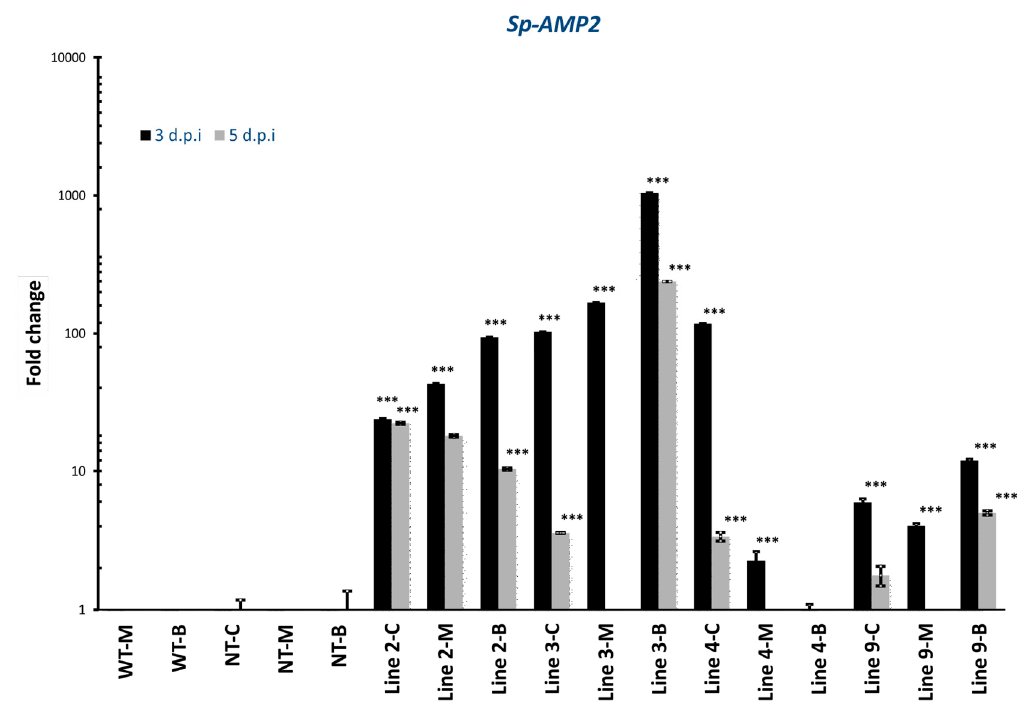
Figure 5. Quantitative real ‐ time PCR analysis of expression patterns of Sp ‐ AMP2 in different tissues and in response to various treatments at 3 and 5 days post ‐ inoculation. Sp ‐ AMP2 relative expression levels were determined as described earlier (Livak and Schmittgen 2001 [34]) and normalized with Elongation factor 1a ( EF ‐ 1a ). WT ‐ M, untransformed wild ‐ type tobacco mock treated with PDB (Potato Dextrose Broth); WT ‐ B, untransformed wild ‐ type tobacco infected with B. cinerea ; NT ‐ C, non ‐ transgenic tobacco not treated control; NT ‐ M, non ‐ transgenic tobacco mock treated with PDB; NT ‐ B, non ‐ transgenic tobacco with independent transgenic tobacco infected with B. cinerea ; Line 2; Line 3; Line 4; Line 9, independent transgenic line expressing Sp ‐ AMP2 with either non ‐ treated control (C), infected with B. cinerea (B), or mock treated with PDB (M). Data represent the fold change of Sp ‐ AMP compared with expression in untreated wild type control plants at the corresponding time points. Error bars indicate the standard error of the mean across three independent biological replicates. Asterisks indicate the level of significance in comparison to non ‐ transgenic plants infected with B. cinerea (NT ‐ B), *** p values < 0.001.